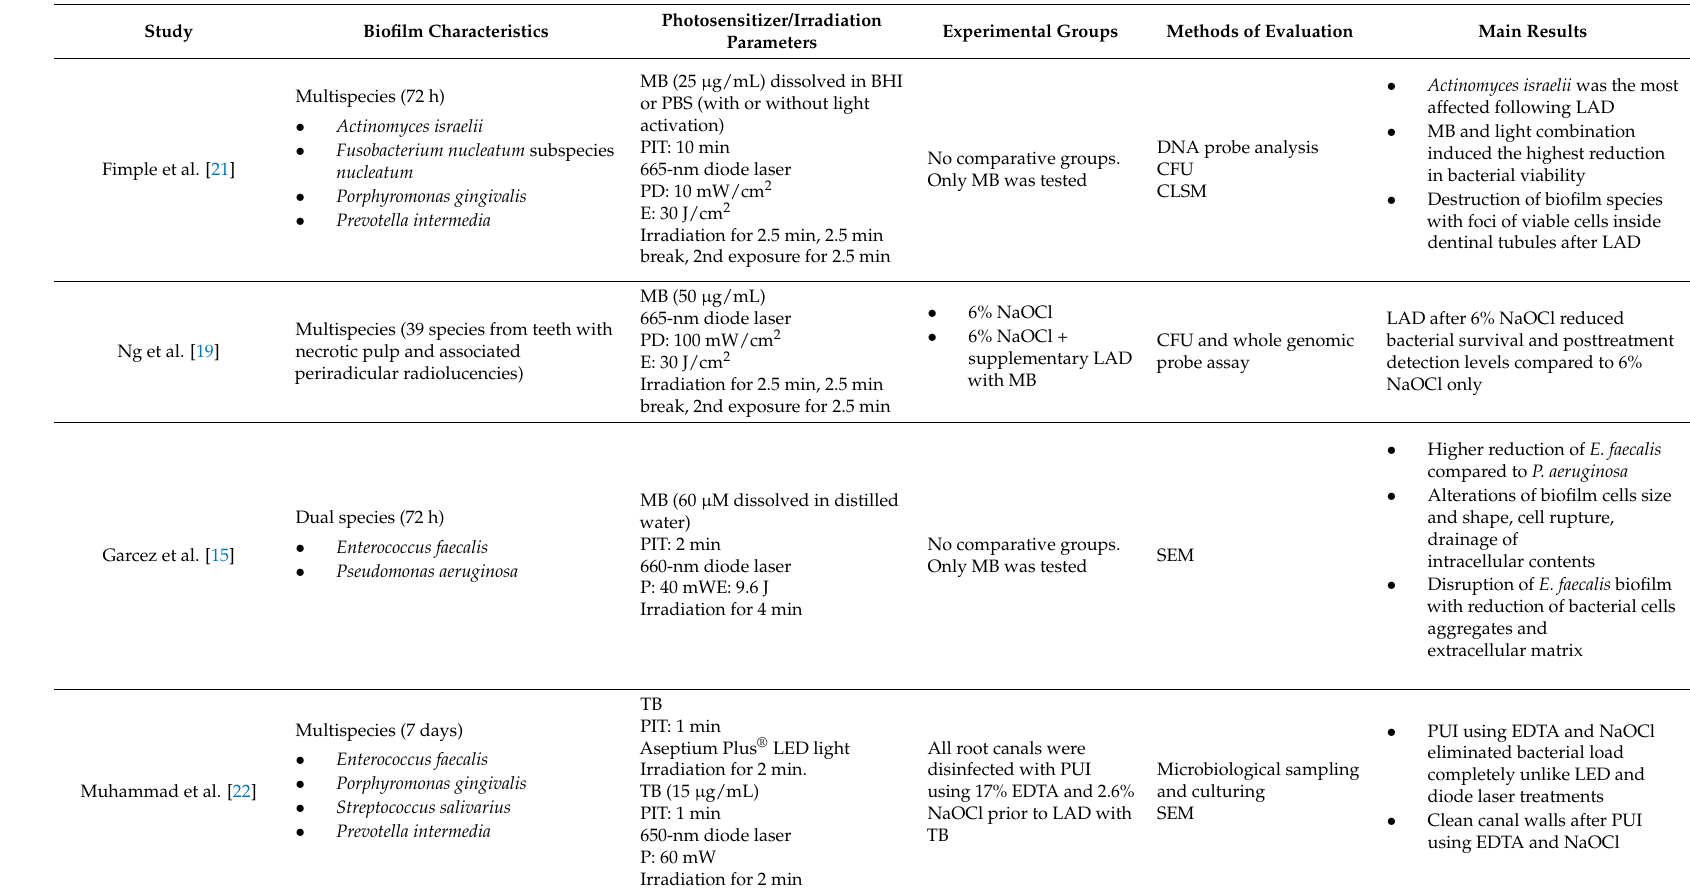
Table 2. General characteristics of included studies on dual- and multispecies